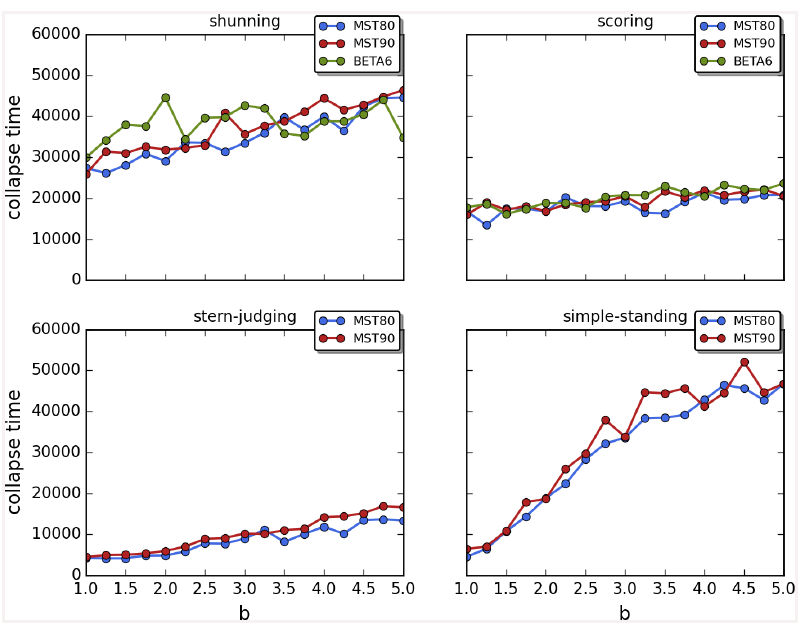
Fig 10. Comparison of the three main scenarios. The figure shows the average time until the collapse of cooperation as a function of the value of the benefit ( b ) for different social norms for the three main scenarios. Colour code: (a) MST80: blue, (b) MST90: red, (c) BETA6: green.